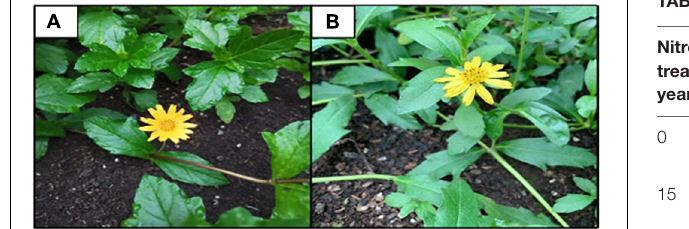
TABLE 1 | Solution ratios of different nitrogen deposition and nitrogen